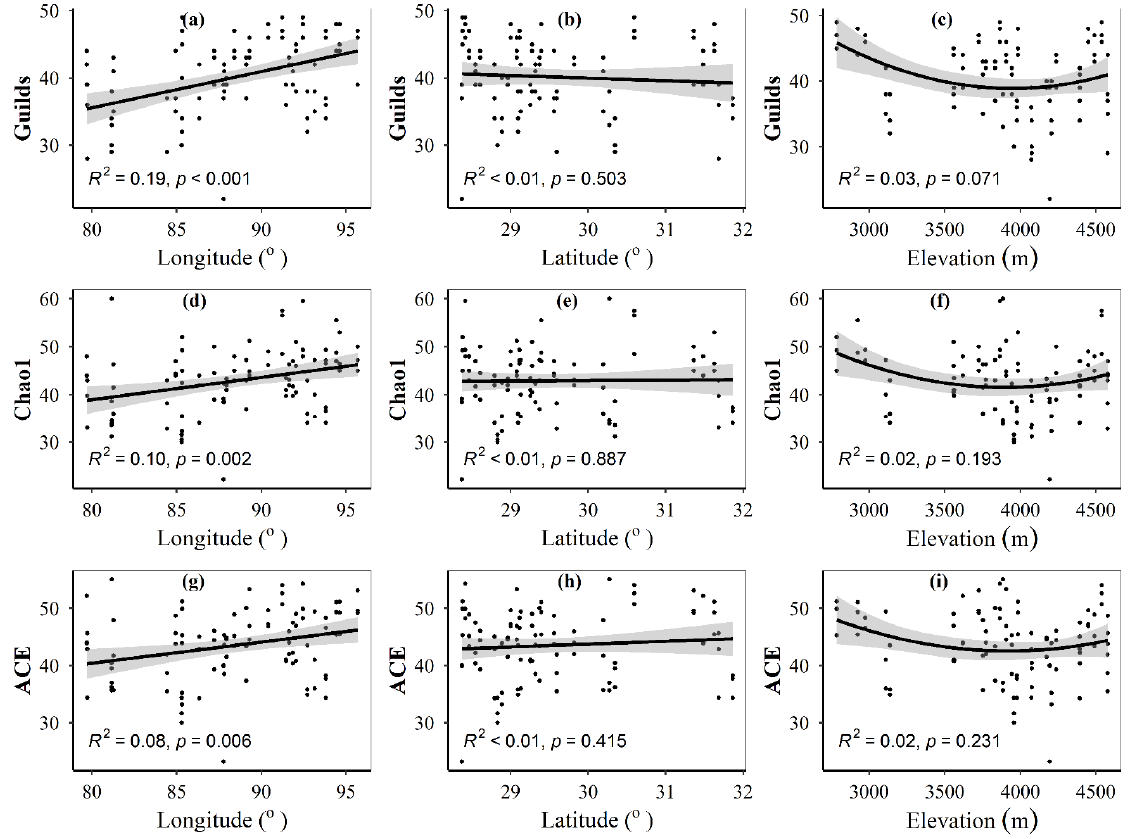
Figure A15. Cont